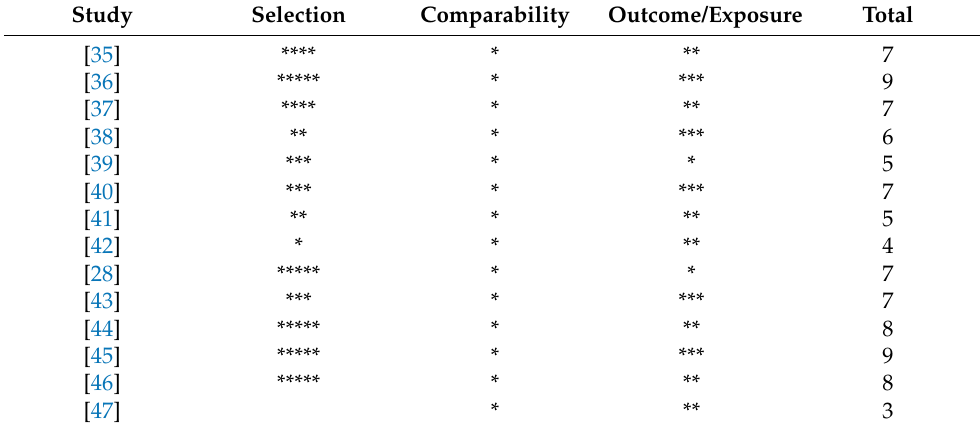
Table 3. Quality Assessment of Included Studies using the Newcastle–Ottawa Scale (each study is allotted the stars (*) for each category (Selection, Comparability and